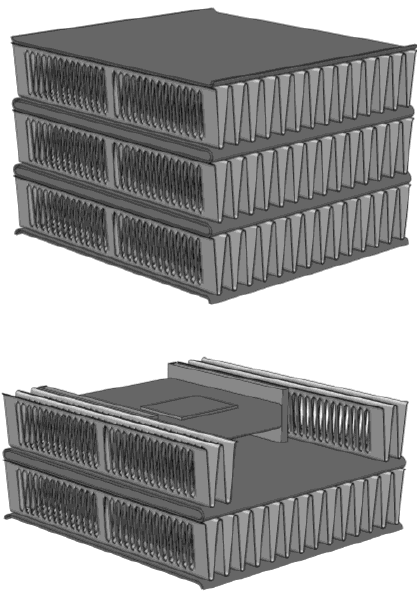
Fig. 2. Heat exchanger segment models: without sensor and with hot film sensor implemented (part of the segment with a view of the sensor location).